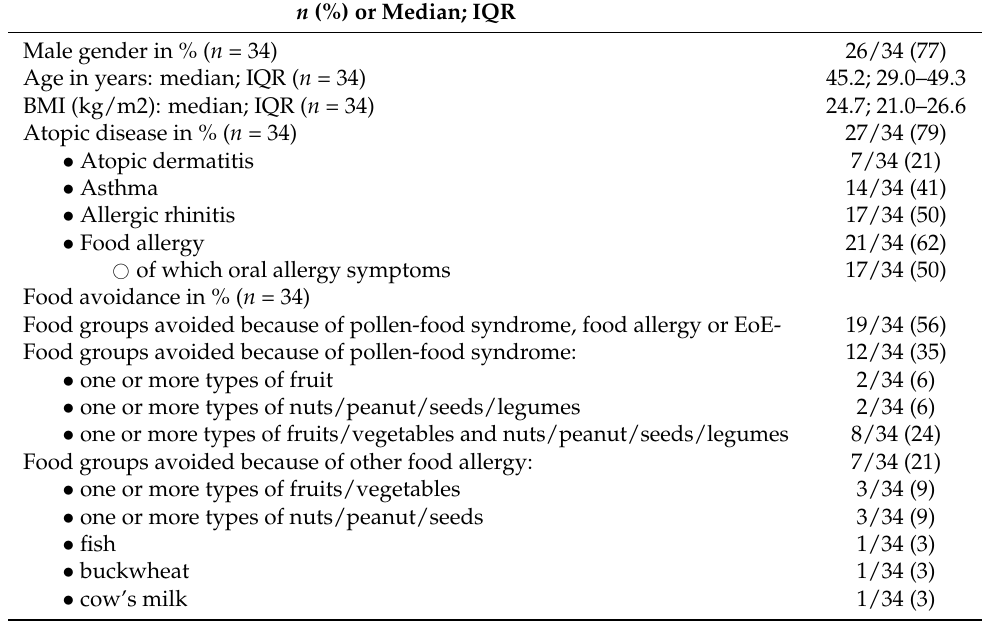
Table 1. Patient characteristics of Eosinophilic esophagitis (EoE) patients ( n = 34) at